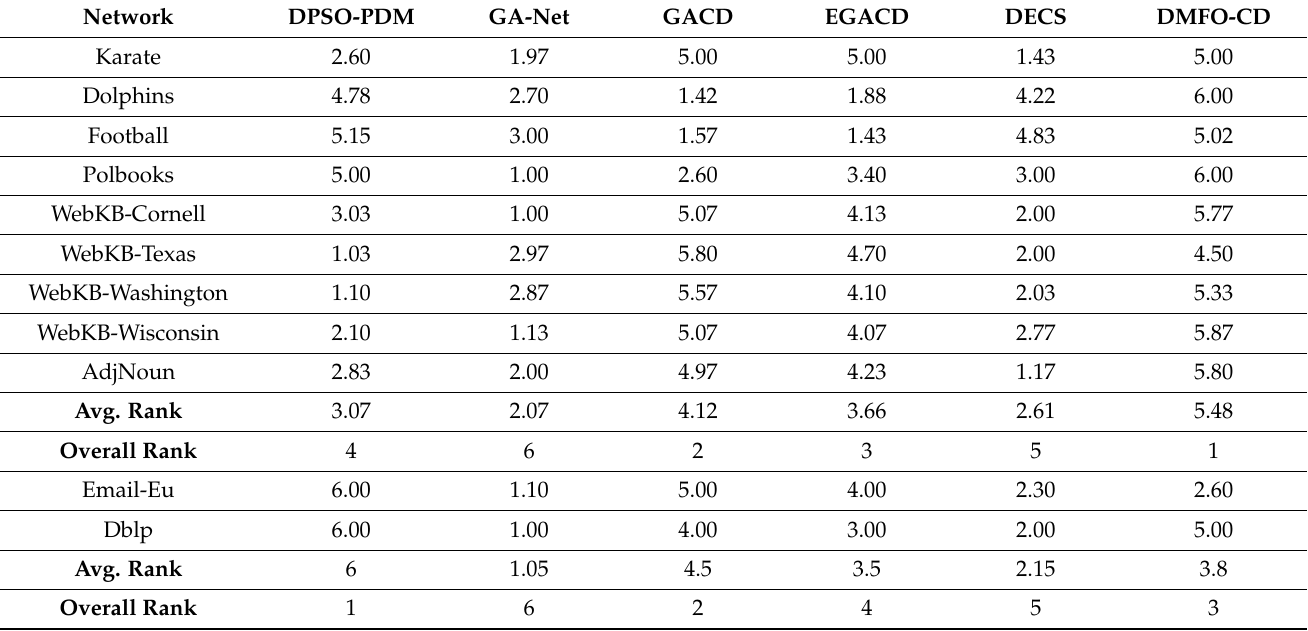
Table 4. The Friedman test on